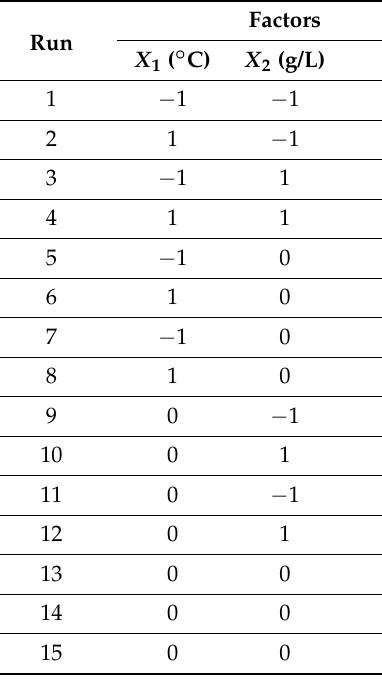
Table 4. Box Behnken matrix and response results for optimization of protease.